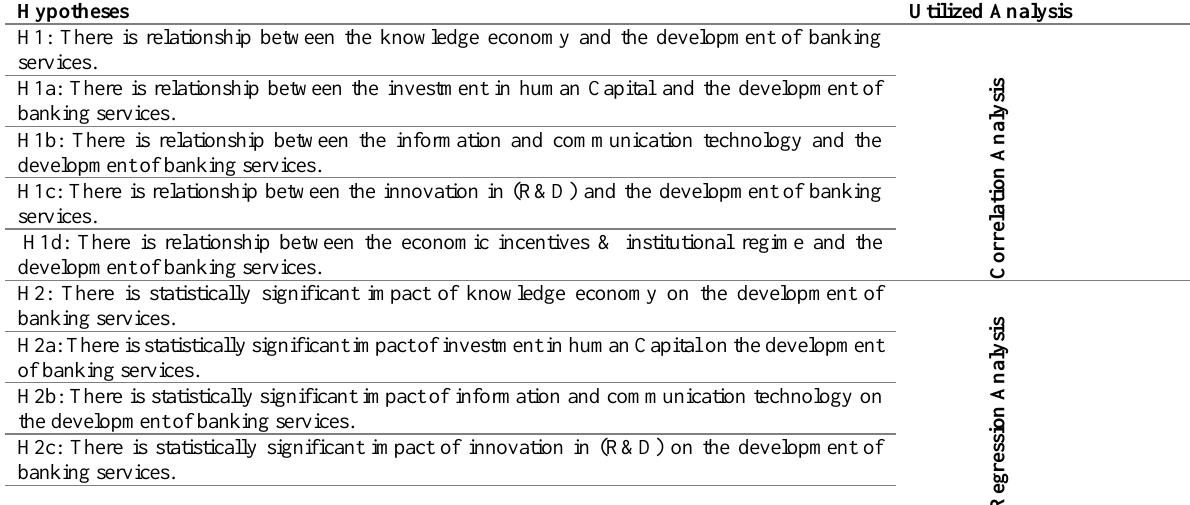
Table 2: The Hypotheses of the Study and The Analyses Used